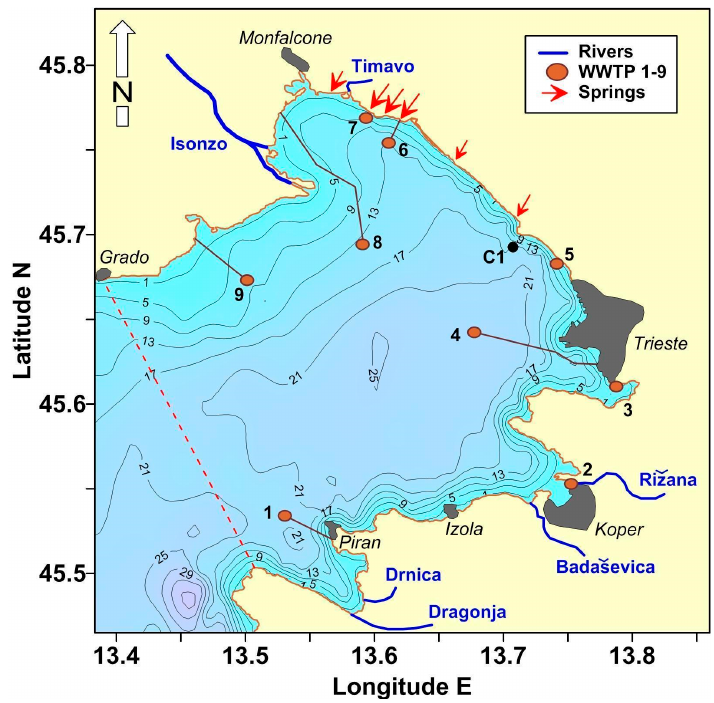
Figure 1. Station C1, rivers (blue lines), main sites where coastal and submarine springs are located (red arrows) and points of discharge of the wastewaters (WWTP) operating during the period of interest in the Gulf of Trieste. Dashed red line indicates the limit of the considered Region of Interest.